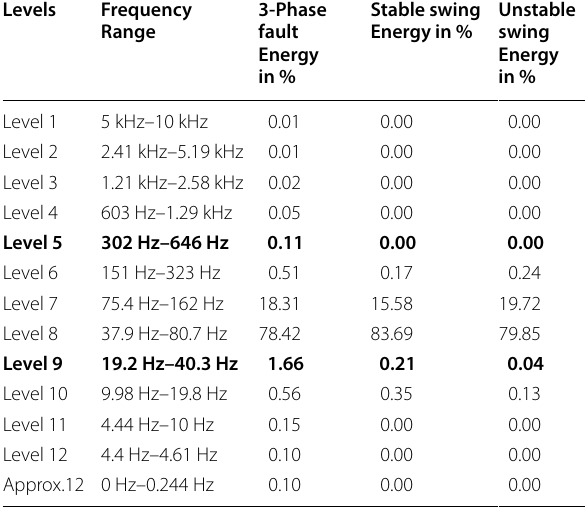
Bold shows the significant difference in % energy among three phase fault, stable swingand unstable swing